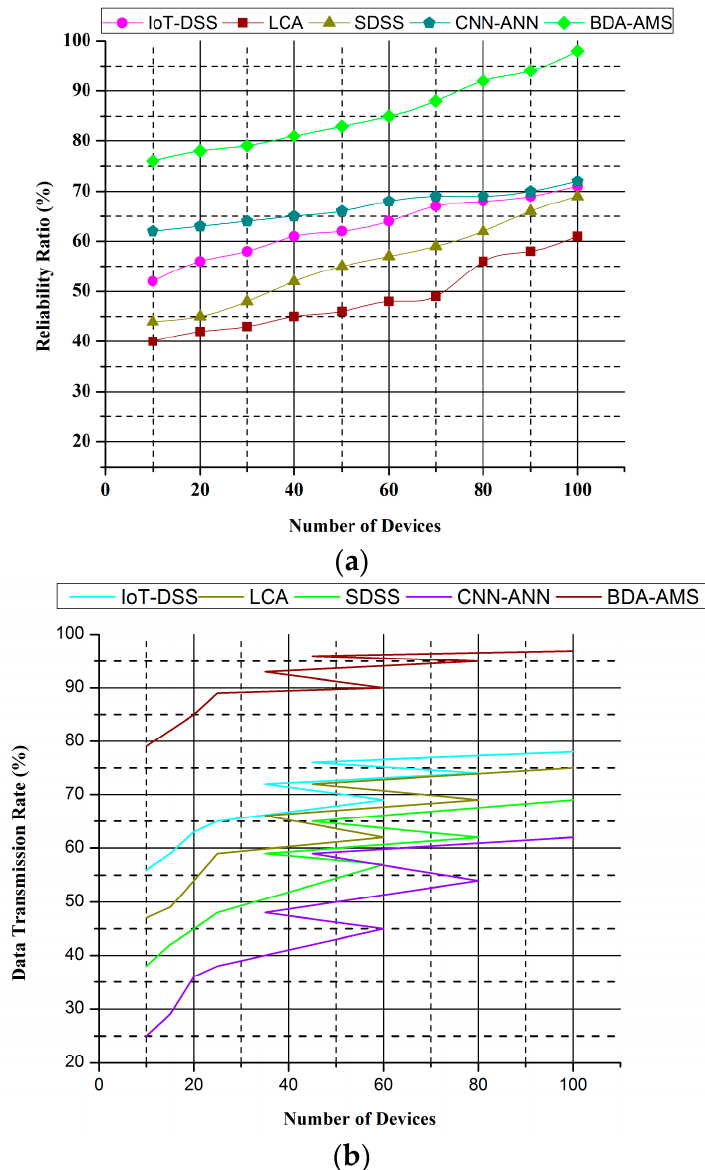
Figure 10. ( a ) Data transmission rate (%). ( b ) Data reliability ratio (%).